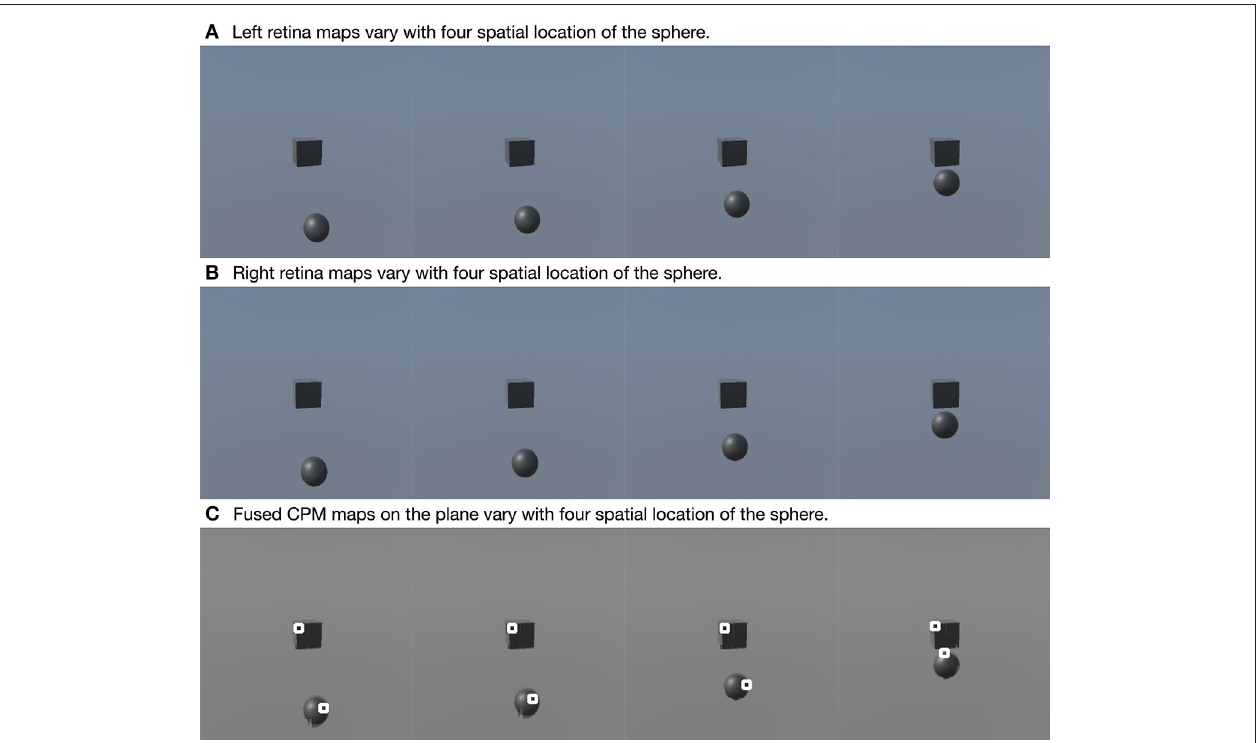
FIGURE 7 | Examples of visual localization. This figure contains three rows and four columns. Each column indicates an example, and three rows are left retina map (A) , right retina map and fused CPM’s projection on the plane (B,C) . In the third row, two white circles are marked on two objects, respectively. These marks indicate the spatial location of two objects determined by the